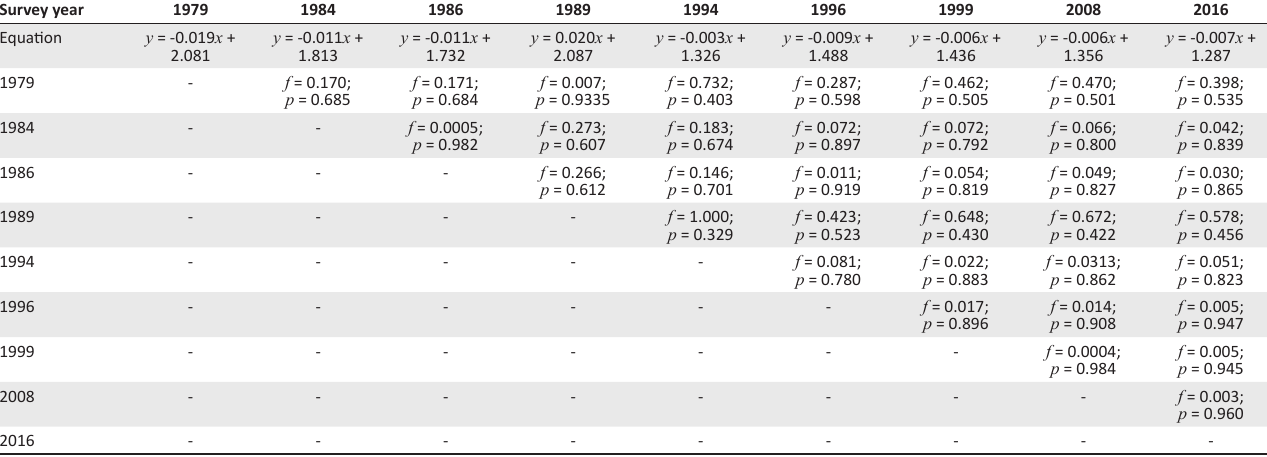
TABLE 2-A1: Statistical comparison of slope values for linear regressions fitted on the density of individuals against the diameter class midpoint of live trees at Grootkolk in the Kalahari Gemsbok National Park using an analysis of covariance. Survey year